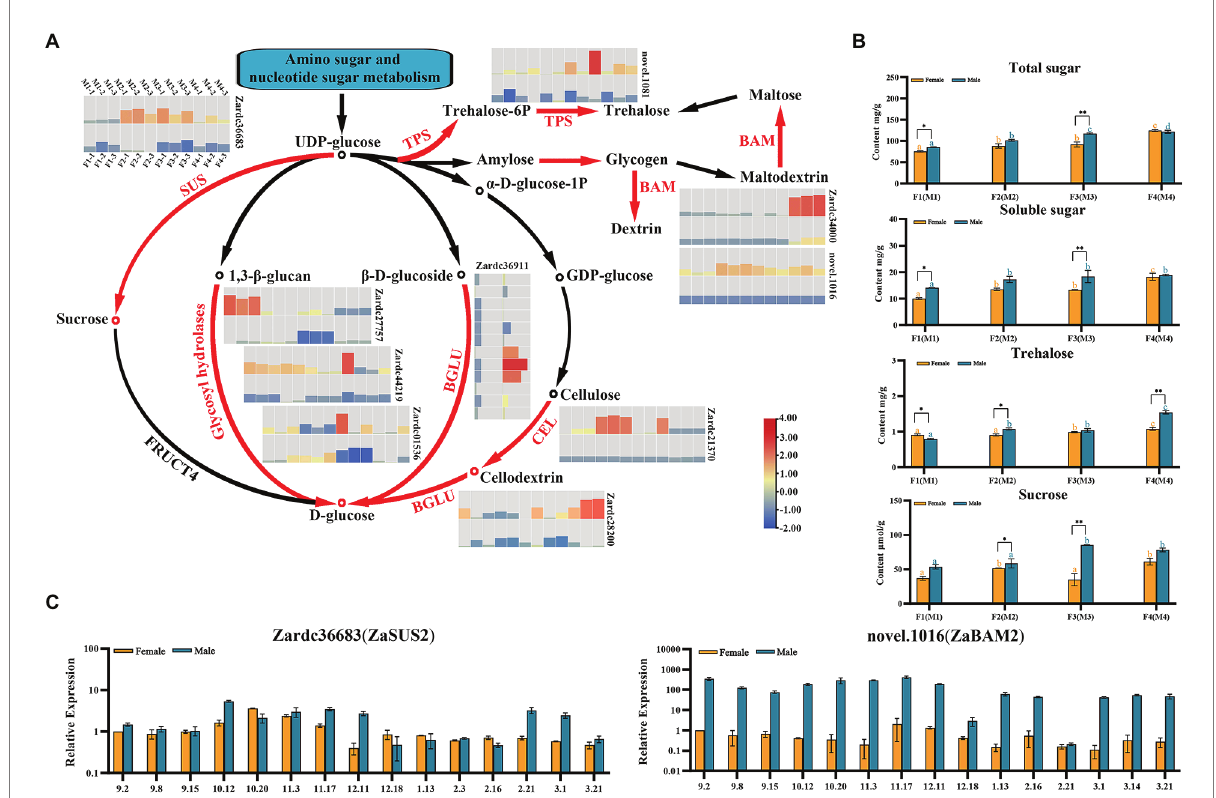
FIGURE 5 The identification of key genes related to sugar compounds biosynthesis pathways enriched in male vs. female comparisons. (A) The biosynthesis cascade of sucrose and starch biosynthesis pathway. Red fonts indicated the homologous differential expressed genes significantly up-regulated in this study. (B) The investigation of four sugar compounds during floral sex differentiation process. * and **, respectively, means p < 0.05 and p < 0.01 between female and male samples. The different orange and blue letters indicated the significant difference (p < 0.05) among differentiation stages for male or female floral buds, respectively. (C) The relative expression of the DEGs during 15 samples of male and female floral development and maturation process. The female sample at 2 September was used as